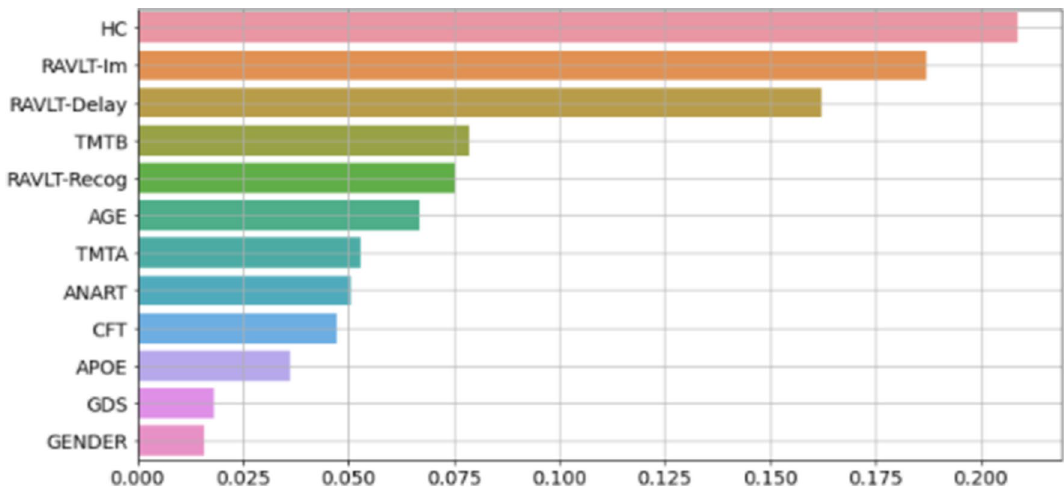
Figure 3. Feature importances calculated by decrease in impurity from evaluation on test set. All the predictors included in the model are displayed on the y-axis while the x-axis depicts their relative importance. 0.0403 ± 0.0503